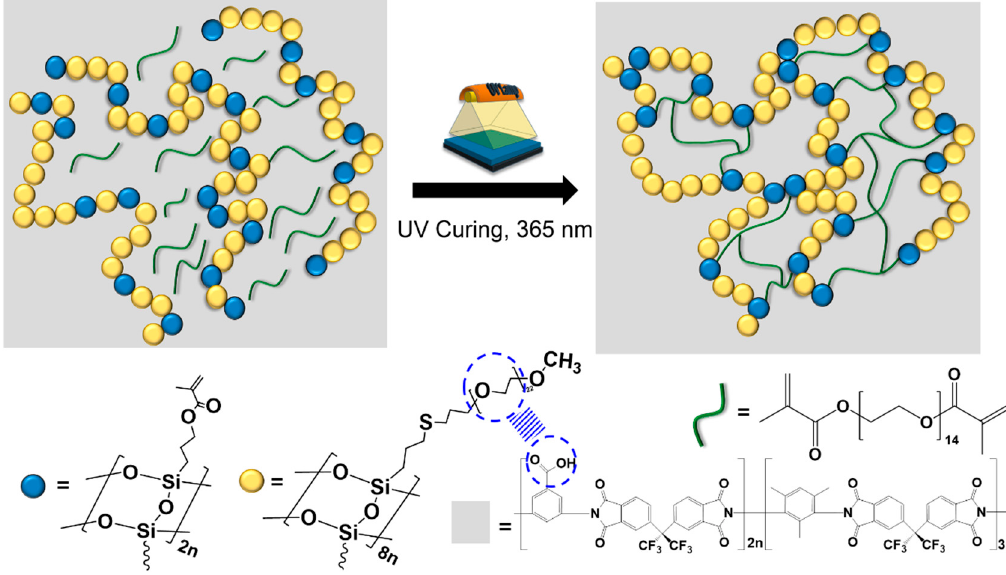
Figure 3. Schematic of UV curing process for hybrid composite and interactions between PI and LPEGMASQ82.